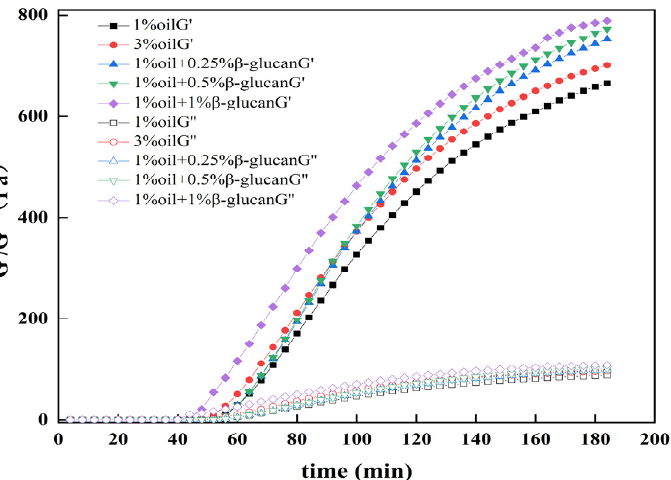
Figure 2. E ff ects of oat β -glucan concentration on the storage modulus (G’) and loss modulus (G’’) Figure 2. Effects of oat β -glucan concentration on the storage modulus (G (cid:48) ) and loss modulus (G (cid:48)(cid:48) ) of of low-fat pea-protein-based yogurt. low-fat pea-protein-based